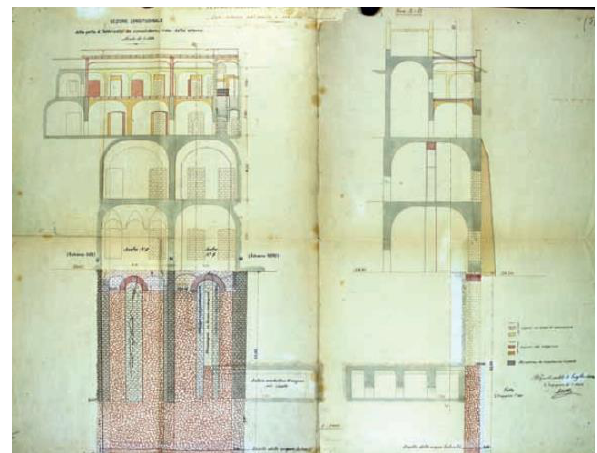
Figure 6. Progetto pel consolidamento dell’ala nord-ovest del